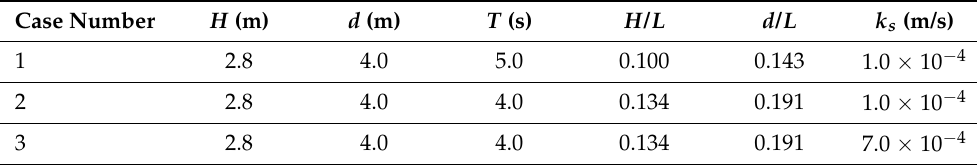
Table 4. Parameters used in numerical